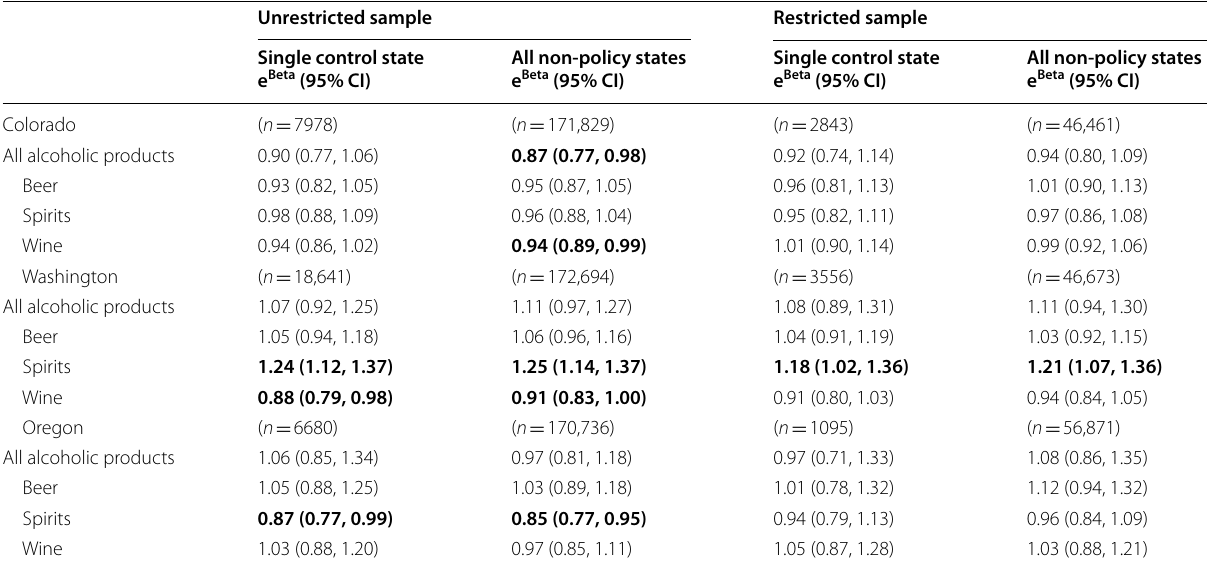
Models are fixed effects linear regression models with robust cluster standard errors, adjusted for household income, household size, marital status, and race. In each model, n is equal to the number of clusters (i.e., households) included for both the policy state and selected control(s). Estimates are exponentiated from log- transformed values to represent the average percent change in mean monthly alcohol purchasing per household following legalization of recreational cannabis. For example, a value of 0.87 corresponds to a 13% decrease while 1.25 corresponds to a 25% increase. The unrestricted sample is all households from 2004 to 2017. The restricted sample is limited to households from 2004 to 2017 that had data both before and after legalization of recreational cannabis in a given policy state. “Single control state” refers to models where a given policy state was compared to a single, matched control state. “All non-policy states” refers to models where controls were all states that did not legalize recreational cannabis. Bolded values represent p values < 0.05